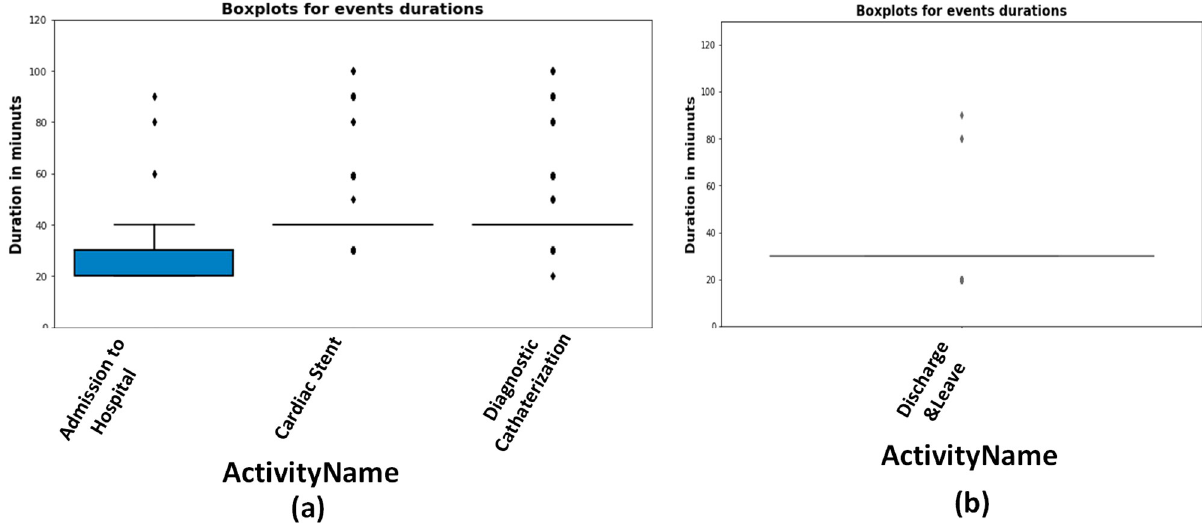
Fig 7. Boxplots for events durations.